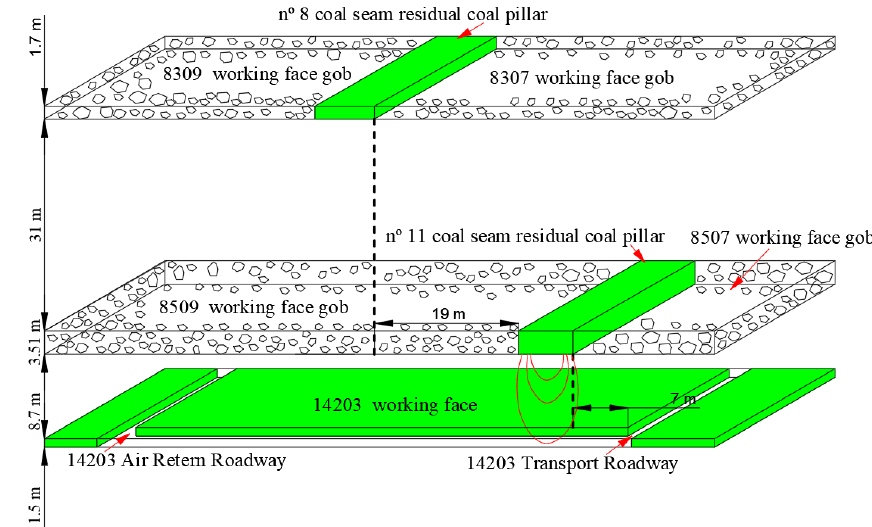
Figure 2. Spatial location of each coal seam.